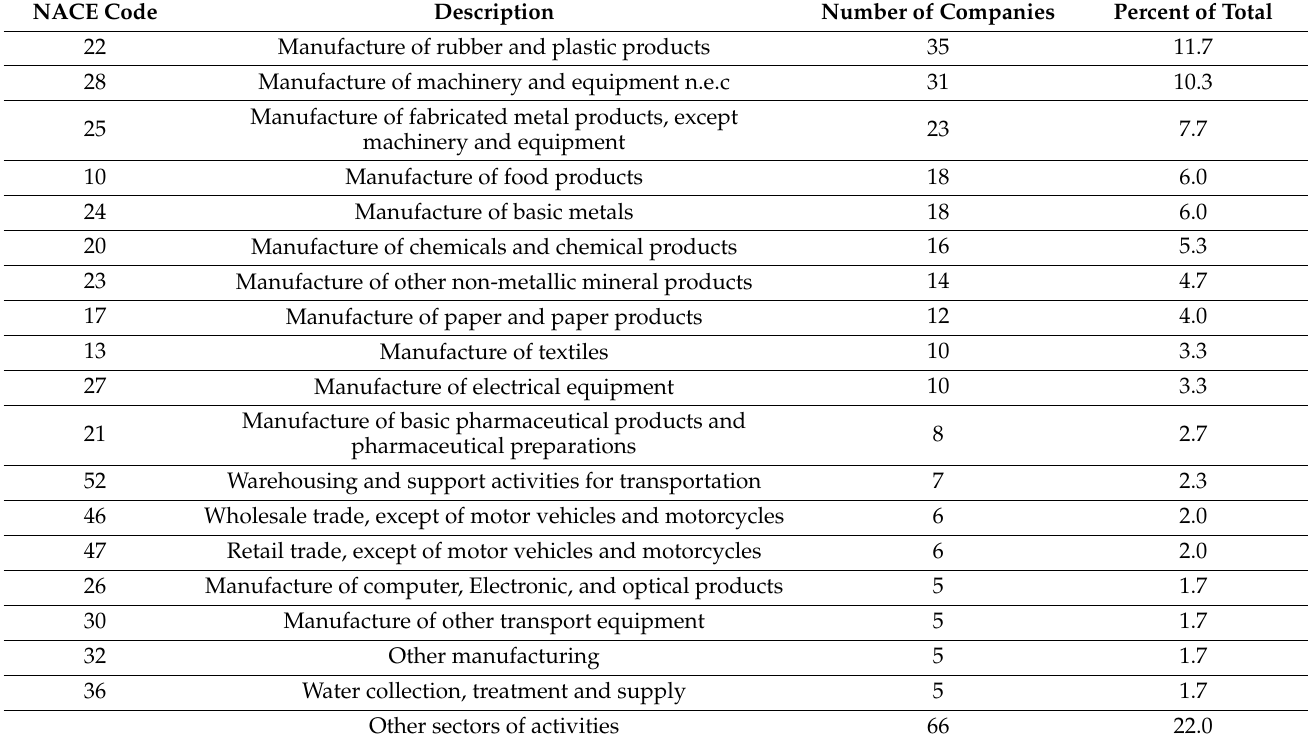
Table 1. NACE economic activities of respondents with a share of more than five